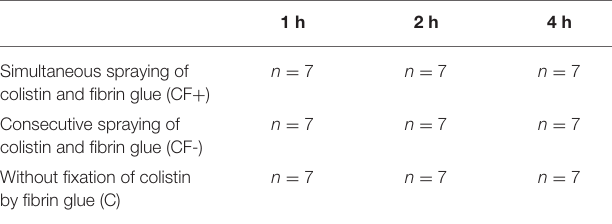
TABLE 1 | Groups, timepoints and number of samples used in the experiment. 1 h 2 h 4